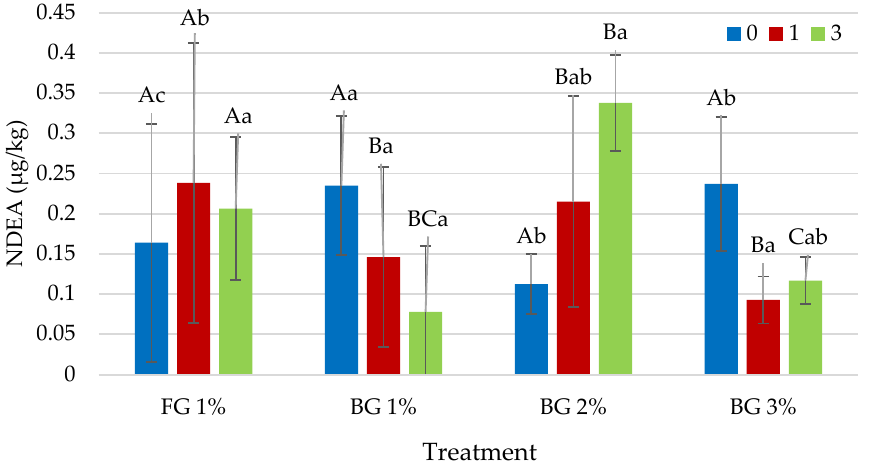
Figure 2. Effect of interaction of garlic treatment × cooking time on N -Nitrosodiethylamine (NDEA) content of heat-treated sucuk (A–C: Different capital letters indicate significant differences between groups with garlic for cooking time. a, b: Different small letters indicate significant differences between cooking time for garlic treatment).